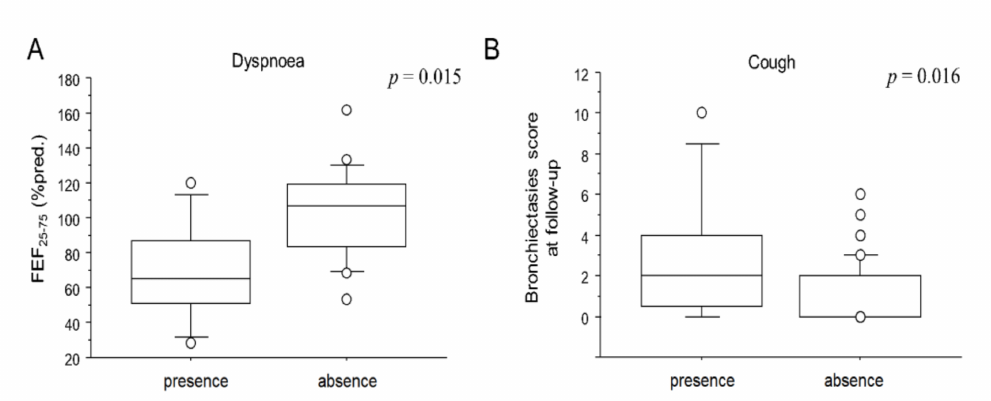
Figure 1. Box plots comparison between the FEF 25-75 and dyspnoea ( A ) and between BRN and cough ( B ) at follow-up visit. Solid line represents the median; bottom and top of the boxes are the 25th and 75th percentiles; brackets correspond to the 10th and the 90th